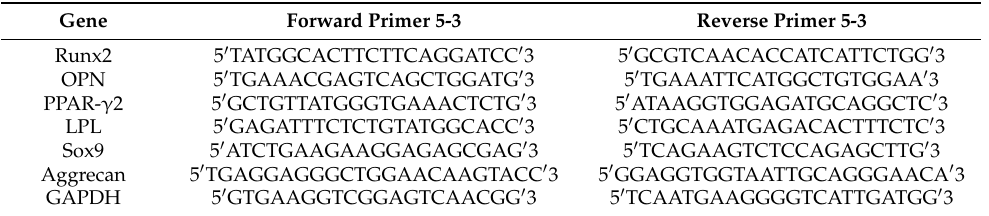
Table 2. Primer oligonucleotide sequences used for real-time PCR.